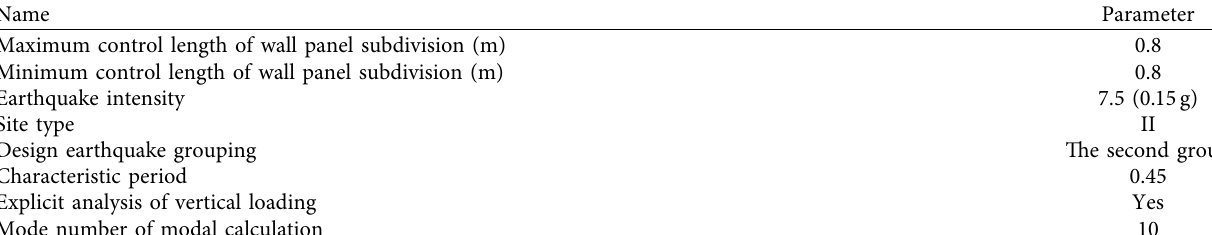
Figure 4: Actual reinforcement diagram of shear wall and beam members. (a) Actual reinforcement drawing of the shear wall. (b) Actual reinforcement drawing of the beam member. Table 1: Structural calculation parameters.